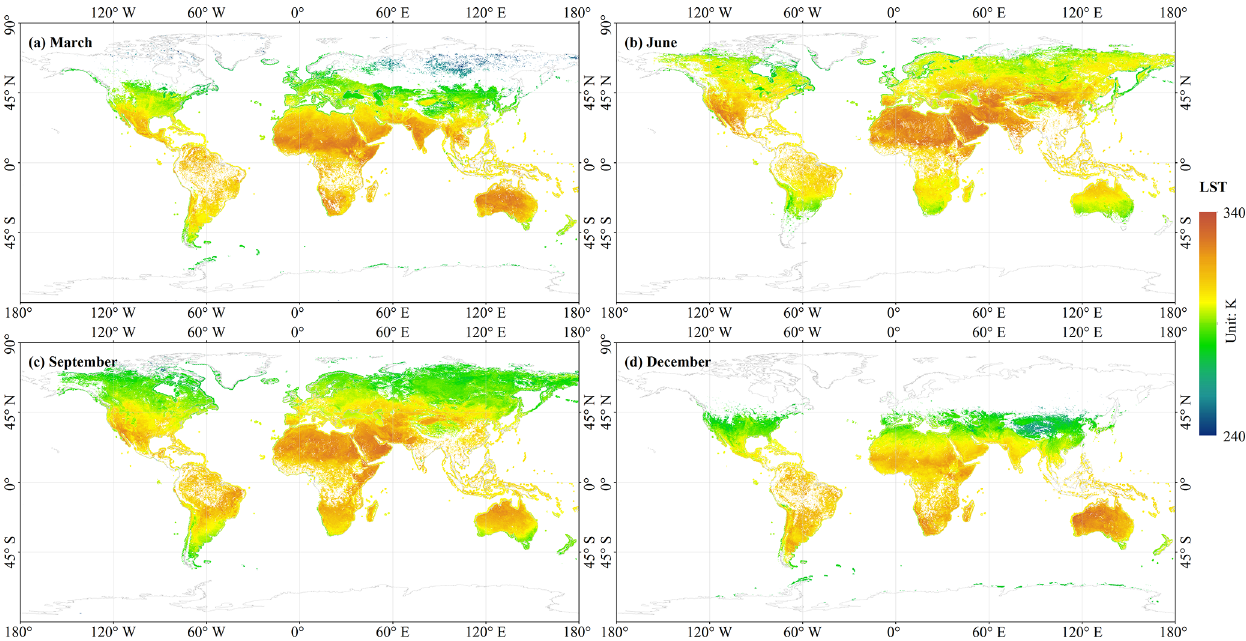
Figure 11. Monthly averaged ODC LST retrieved from NOAA-14 data for 1999 normalized to 14:30ST: (a) March, (b) June, (c) September, (d)